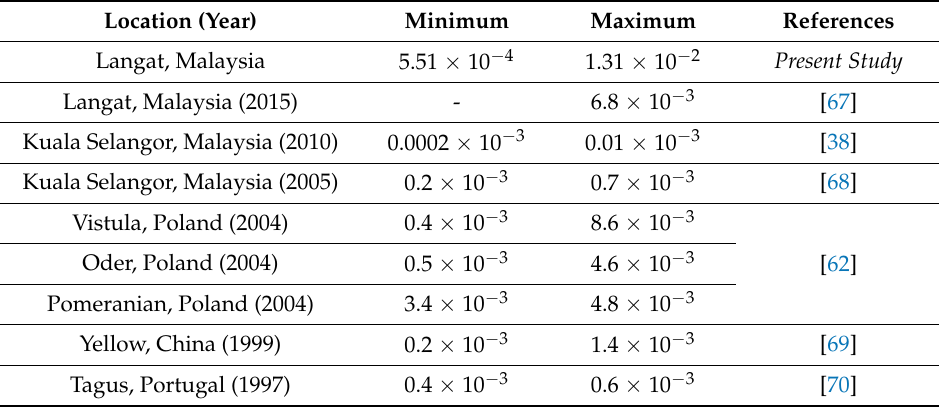
Table 7. Annual effective dose of Po-210 (mSv/year) based on river water